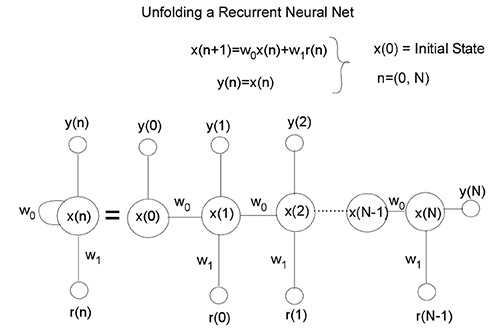
The unfolding of a one dimensional recurrent neural net over time. The Back propagation through time (BPTT) algorithm can be used to identify the weights.